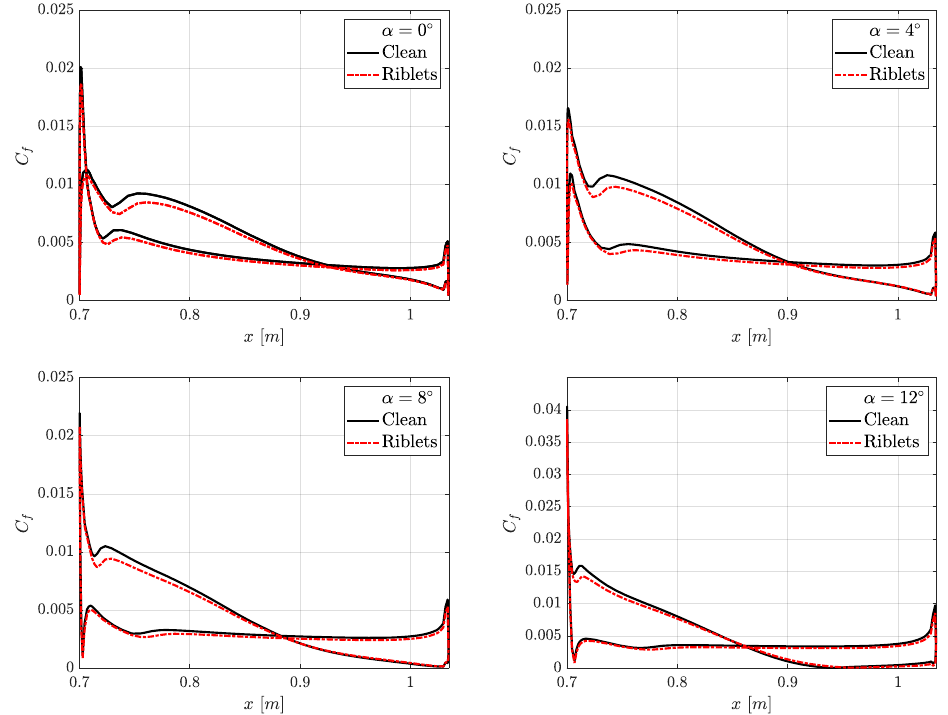
Figure 9. Friction coefficient for the isolated UAV wing, at spanwise location 2 y / b = 0.52 and four angles of attack.